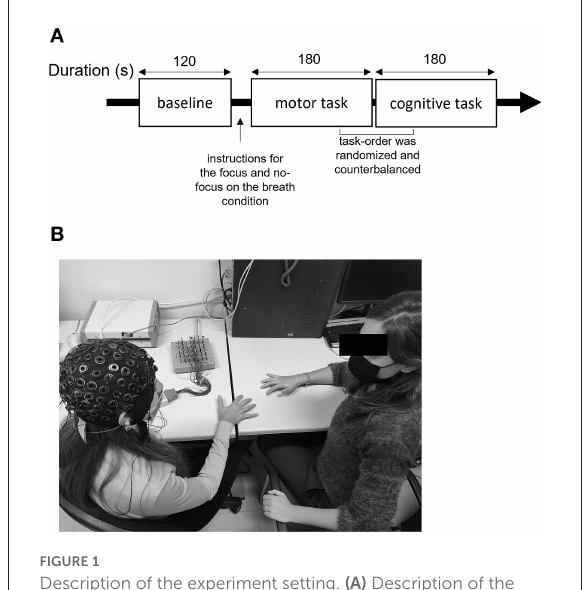
FIGURE1 Description of the experiment setting. (A) Description of the procedure including baseline, motor, and cognitive synchronization tasks with and without focus on the breath manipulation. (B) Experimental setup, where the researcher performs the motor synchronization task and EEG equipment is used to collect the